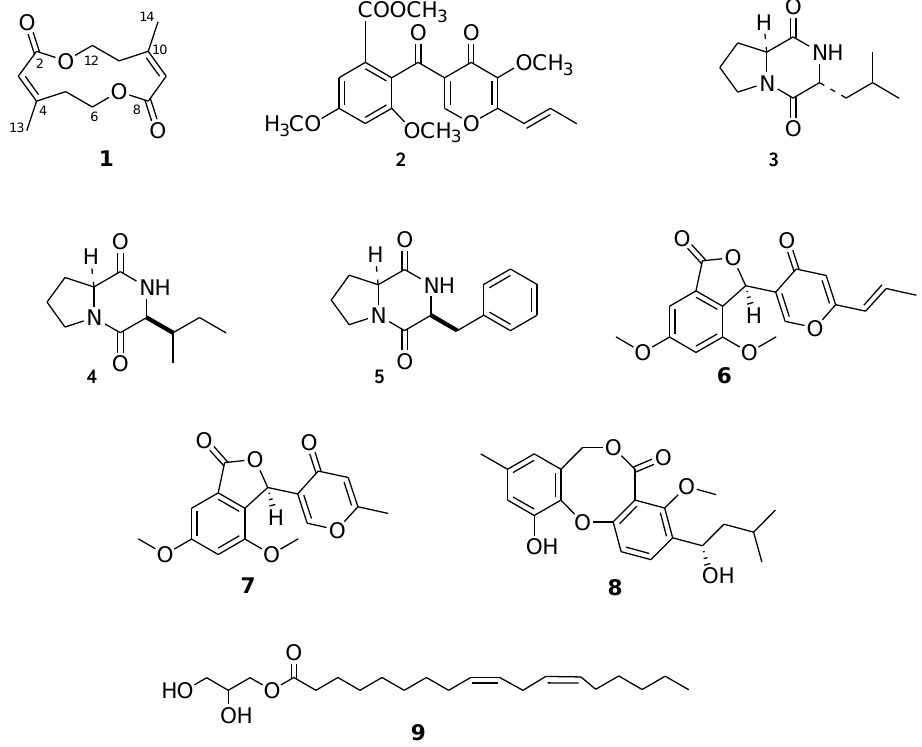
Figure 1. Structures of talarodiolide, 3- O -methylfunicone, cyclo -( S -Pro- R -Leu), cyclo -( S -Pro- S -Ile), cyclo -( S -Pro- S -Phe), vermistatin, penisimplicissin, penicillide, and 1-glycerol-linoleate ( 1 – 9 ), compounds produced by Talaromyces pinophilus LT6, isolated by preparative chromatographic methods and identified by spectroscopic and MS techniques.